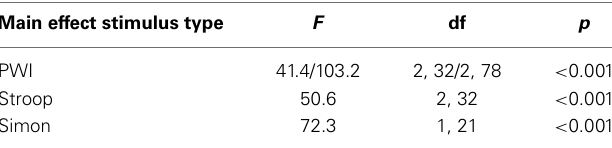
Table 3 | Results of the analyses of variance on response times for the main effect of stimulus type in the picture-word interference, Stroop, and Simon tasks.